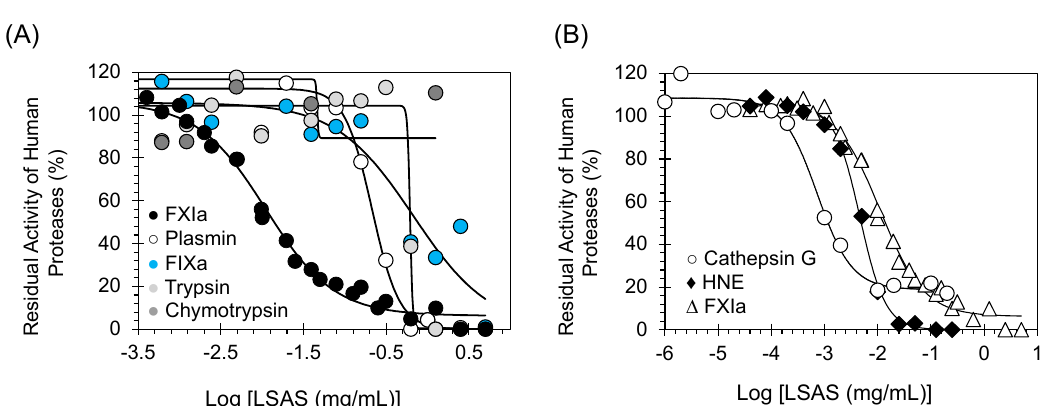
Figure 3. ( A ) Direct inhibition of serine proteases (including human FXIa) by LSAS. ( B ) Direct inhibitions of FXIa and the inflammatory serine proteases cathepsin G and HNE by LSAS. The inhibition of FXIa, plasmin, FIXa, trypsin, chymotrypsin, HNE, and cathepsin G by LSAS was studied as described in Methods and Materials. Solid lines are the sigmoidal dose–response fits (Equation (1)) to the data to obtain the inhibition parameters.